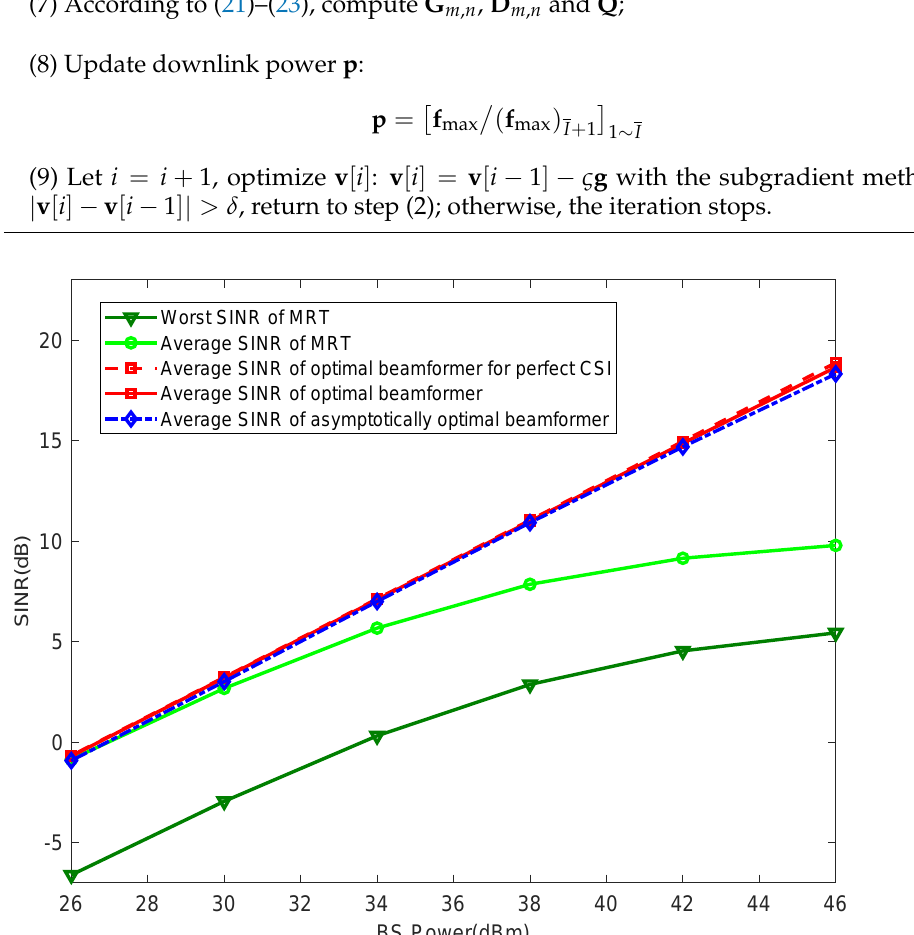
Figure 2. The achieved SINR among several algorithms with regard to P ( M = 64, I = 4, K = 3, r = 0.1, τ =